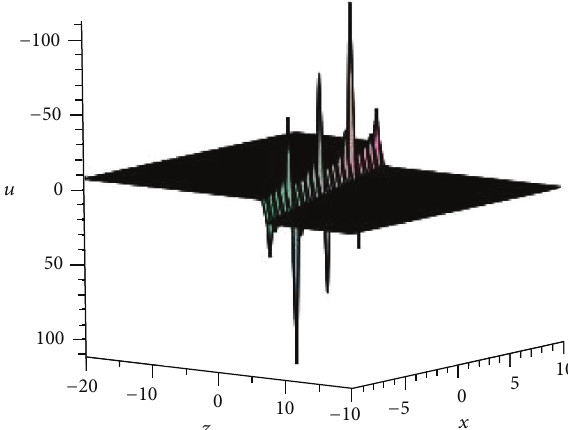
Figure 5: The shape of the 1-negaton of first-order to (1) with 𝜆 1 = = 0 . −4 , 𝑦 = 0 , 𝑡 = 0 , 𝛾 1